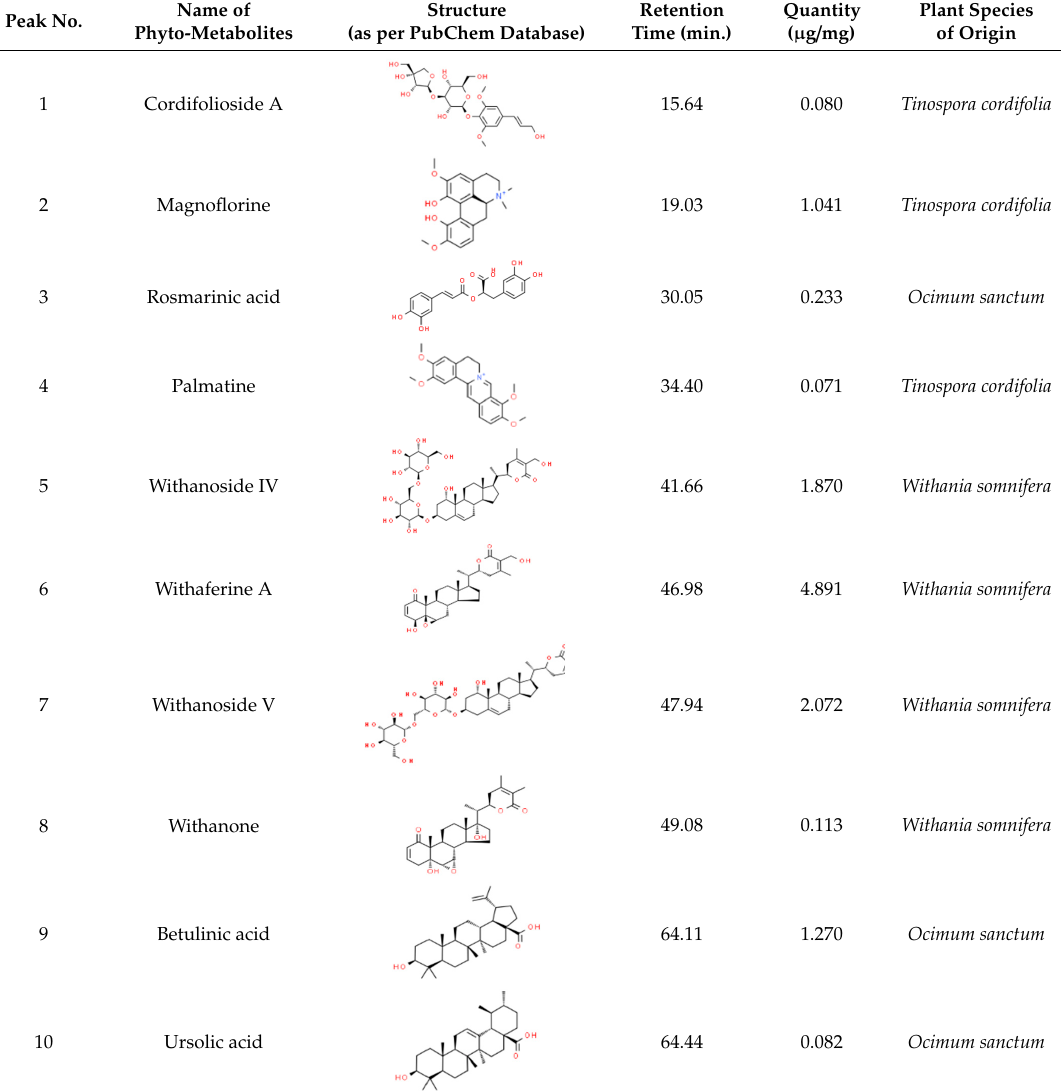
Table 1. Ultra-high-performance liquid chromatography (UHPLC) analysis of Coronil phyto-metabolites, as per the chromatograms shown in Figure 1.